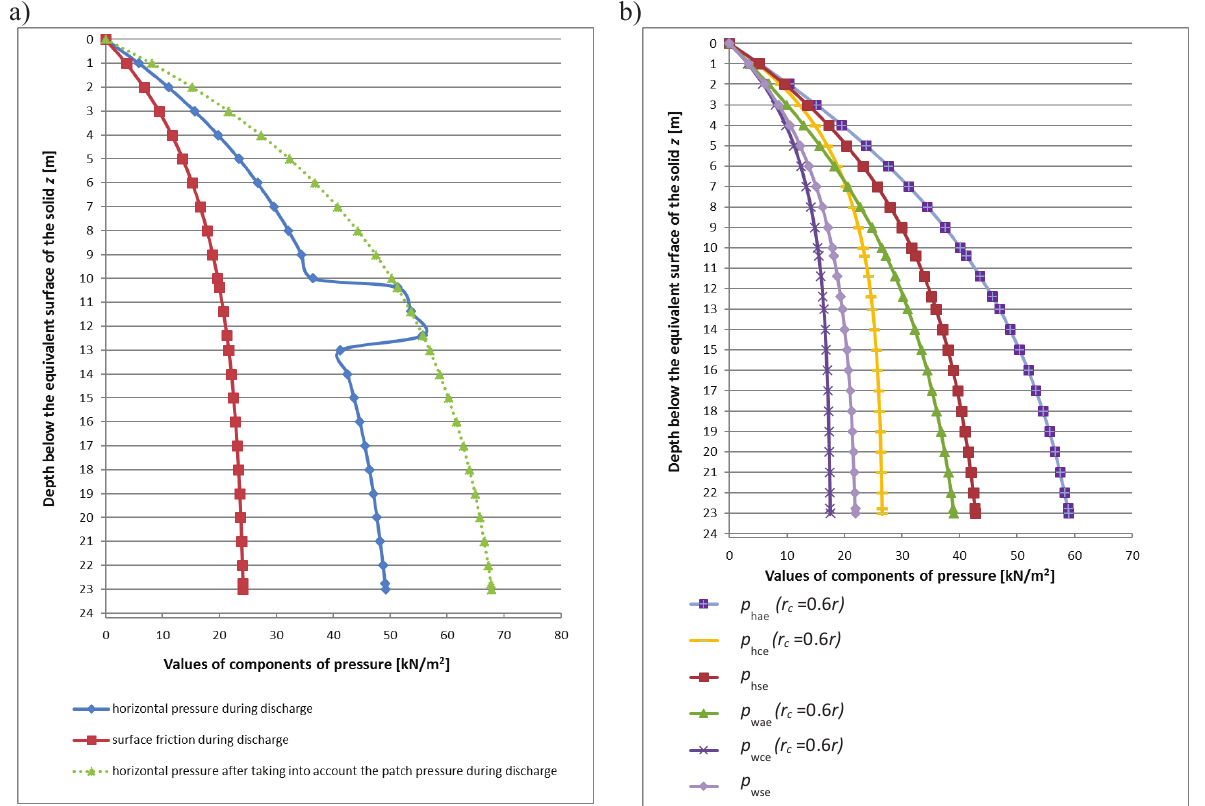
=10 m and height H =25 m during emptying on c